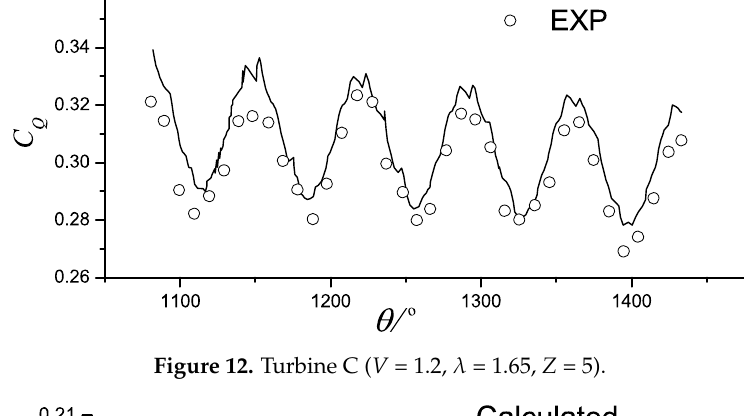
Figure 11. Turbine B ( V = 1.2, λ = 2.2, Z = 3).